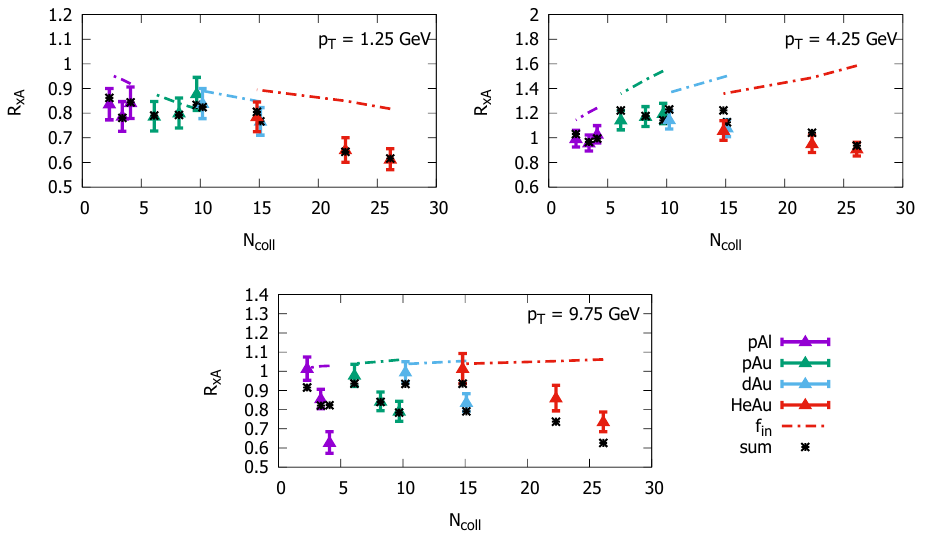
Figure 3. Nuclear modification factor as a function of the number of binary collisions for three values of transverse momentum, p T . Dot-dashed lines represent the calculation without thermal effects by using only f in . The black “ × ” symbols correspond to the full calculation given by Equations (6)–(9). Data from PHENIX Collaboration [30].